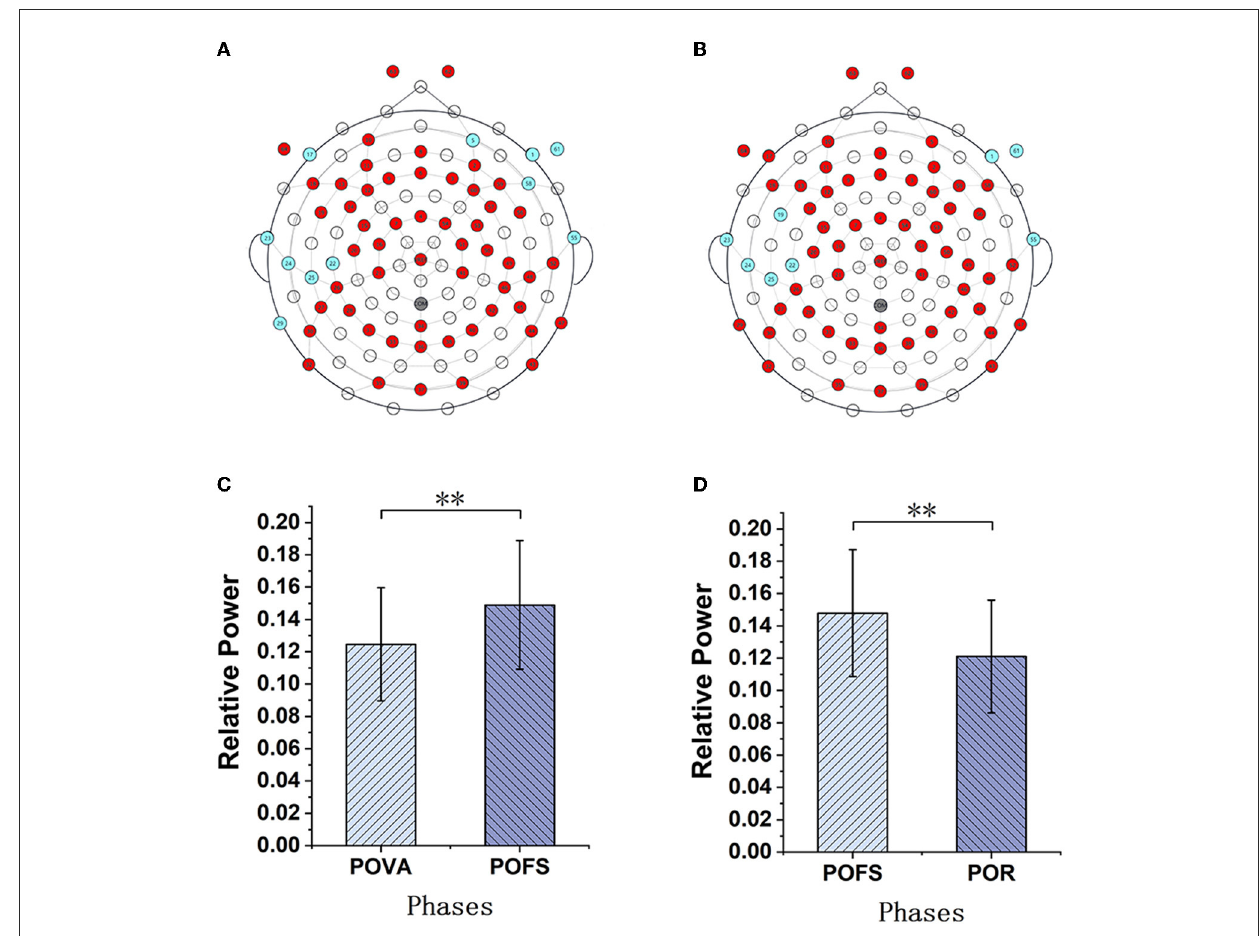
FIGURE3 The comparison of theta power in different phases. (A) and (B) are the brain topography distributions of selected channels in the POVA and POFS comparison and POFS and POR comparison, respectively. In the brain topography, the red dots are channels with a significant difference from the comparison of the two phases, the blue dots are channels without significant differences, and the white dots are empty channels. According to the chosen channels shown in red in (A, B) , the average relative power changes for POVA and POFS comparison and POFS and POR comparison, respectively, are shown in (C, D) . ** p <